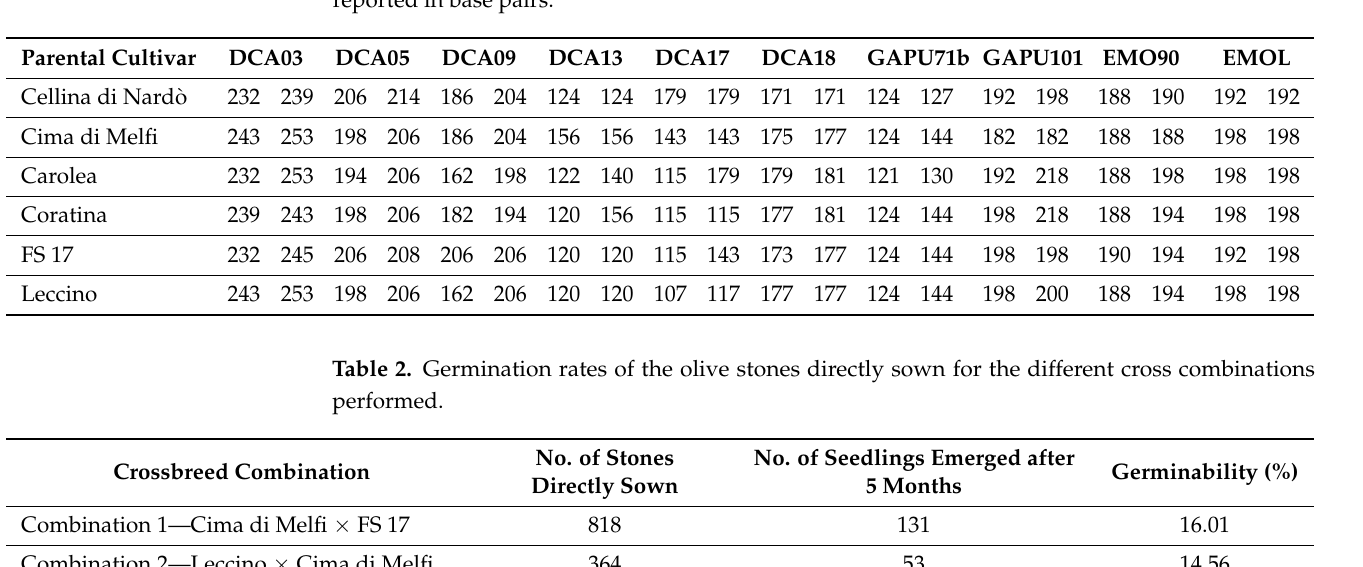
Table 1. Allelic profile obtained for each parental olive cultivar using 10 SSR markers. Allele size is reported in base pairs.